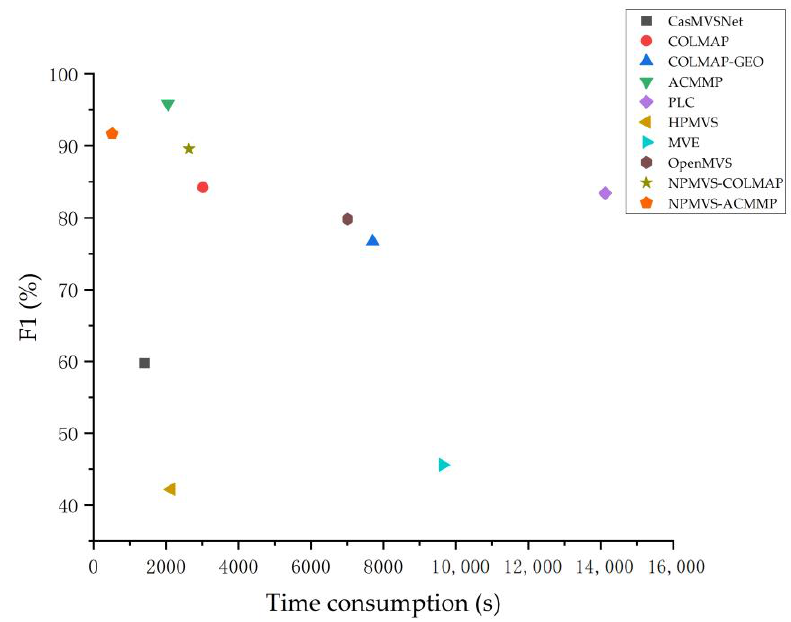
Figure 4. Scatter plot of time consumption and F1